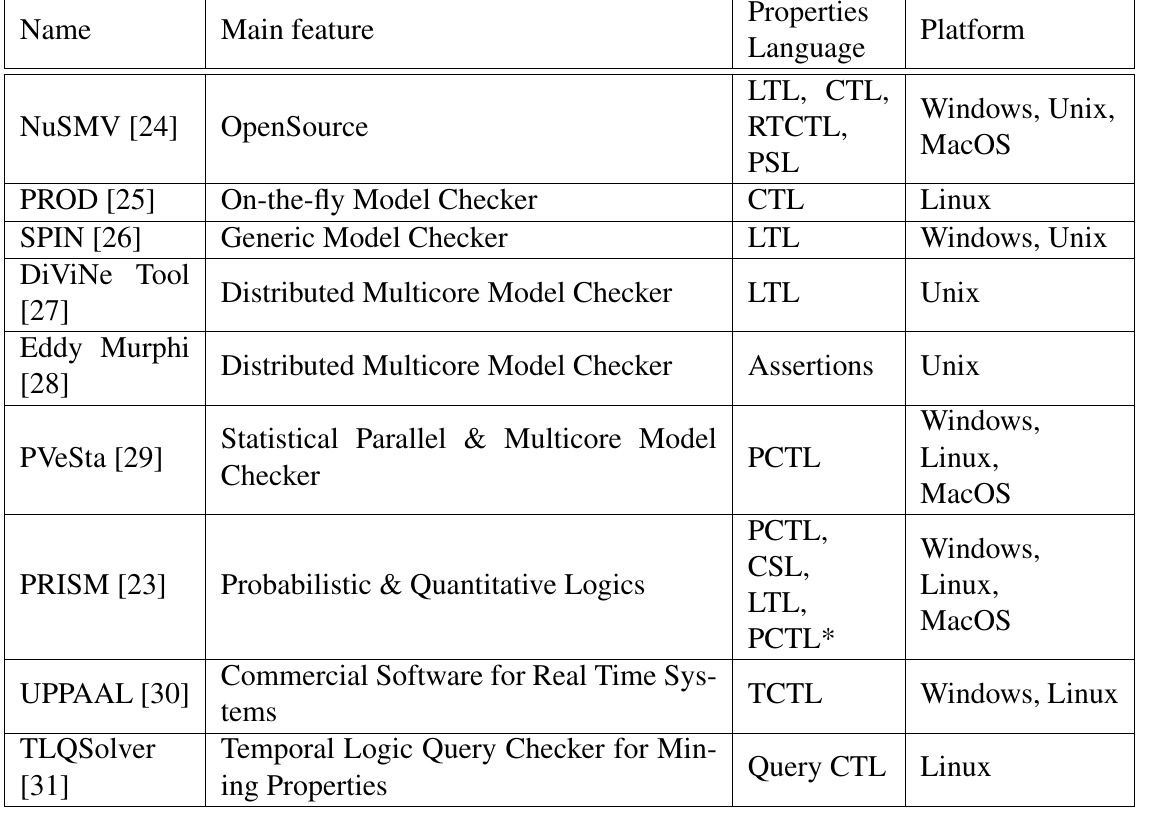
Table 1: List of some available model